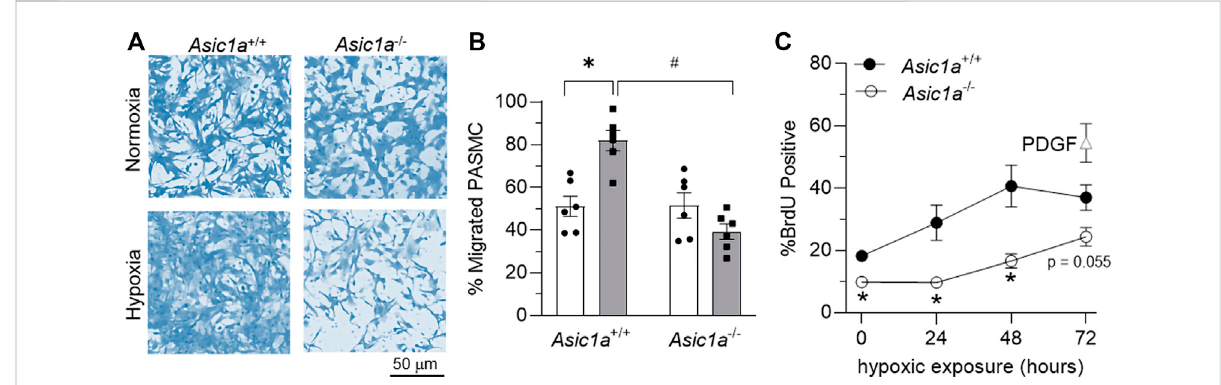
FIGURE 7 ASIC1a contributes to mPASMC migration and proliferation. (A) Representative bright fi eld images of coomassie-stained mPASMC and (B) summary data for % of migrated mPASMC from Asic1a +/+ and Asic1a − /- mice exposed to normoxia (5% CO 2 , 95% air; orange circles) or hypoxia (5% CO 2 , 2% O 2 ; blue squares) for 24 h n = 6 animals/group; * p < 0.05 vs. hypoxia and # p < 0.05 Asic1a +/+ ; analyzed by two-way ANOVA. Signi fi cant interactions between the individual groups ( p = 0.0003) compared using Š ídák ’ s multiple comparisons tests. (C) Flow cytometry analysis of percentofmPASMCfrom Asic1a +/+ and Asic1a − /- micewithBrdUincorporationundernormoxia(0h;5%CO 2 ,95%air)orhypoxia(5%CO 2 ,2%O 2 )for 24, 48, or 72 h. Normoxic mPASMC from Asic1a +/+ were incubated with PDGF-BB (20 ng/ml) for 72 h as a positive control. n = fi ve to eight animals/ group, analyzed by unpaired t-tests at each time point, * p <